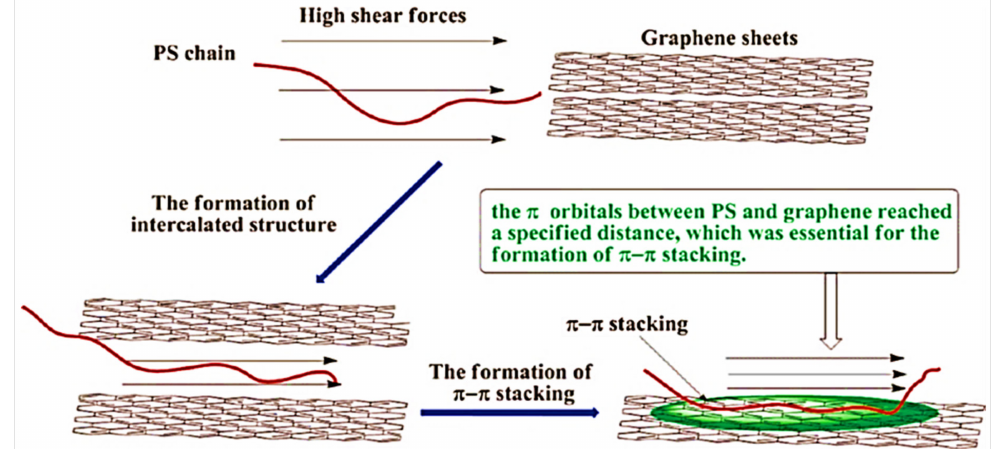
Figure 6. Schematic for the formation of π – π stacking during melt blending [59]. PS = polystyrene. Reproduced with permission from ACS.